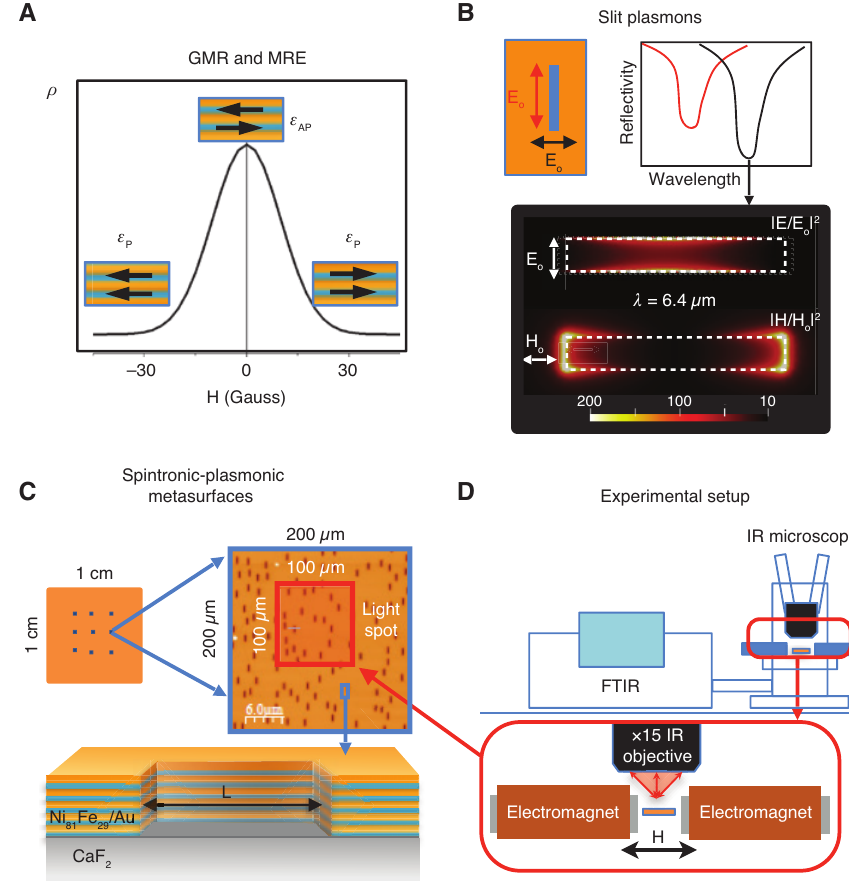
Figure 1: Modulation physical mechanism, selected resonant elements and experimental setup. (A) In a giant magnetoresistance multilayer the magnetizations of the ferromagnetic layers can be switched from antiparallel (AP) to parallel (P) configuration by the application of a magnetic field. This produces a change in the electrical resistivity ( ρ ) and, therefore, a change in the dielectric constant ε ( ε , ε ). (B) A slit in a continuous multilayer has longitudinal (red) and transverse (black) plasmon resonant AP P modes. The near electromagnetic field enhancement reveals the longitudinal magnetic dipolar pattern for the transverse polarization of the exciting electric field. (C) By focused ion beam patterning techniques it is possible to fabricate a wide variety of slit arrays in a single 1 cm 2 sample. We have fabricated several 200 μ m × 200 μ m slit disordered arrays in a Ni Fe /Au multilayer with varying slit length and areal 81 21 concentration. (D) Slit arrays are measured in a FTIR-IR microscope setup with a ferrite electromagnet in the near vicinity of the sample. Reflectivity and magnetic modulation of the reflectivity are measured in 100 μ m × 100 μ m areas of each